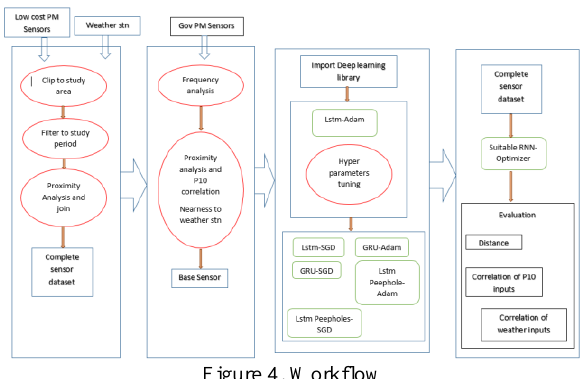
Figure 4. Workflow